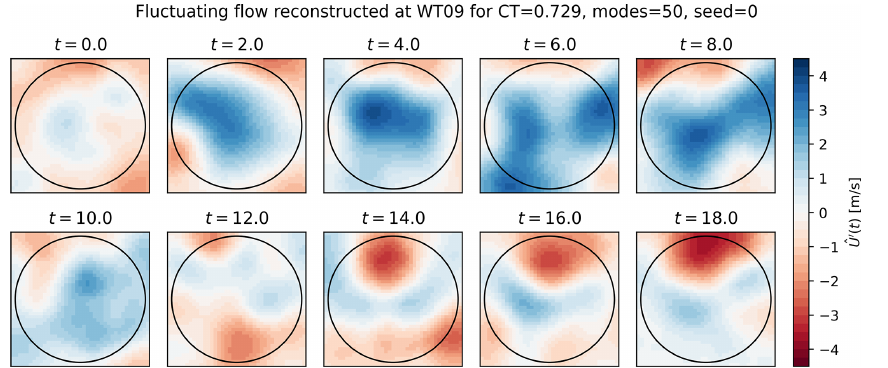
Figure 13. Instantaneous snapshots of the stochastic realizations of the streamwise velocity fluctuations in a wake with C T = 0 . 729 predicted with PS-ROM using 50